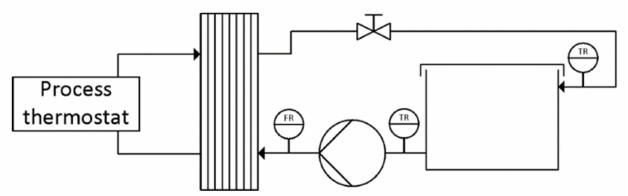
Figure 9. Schematic of stability testing device “ISE capsules”.